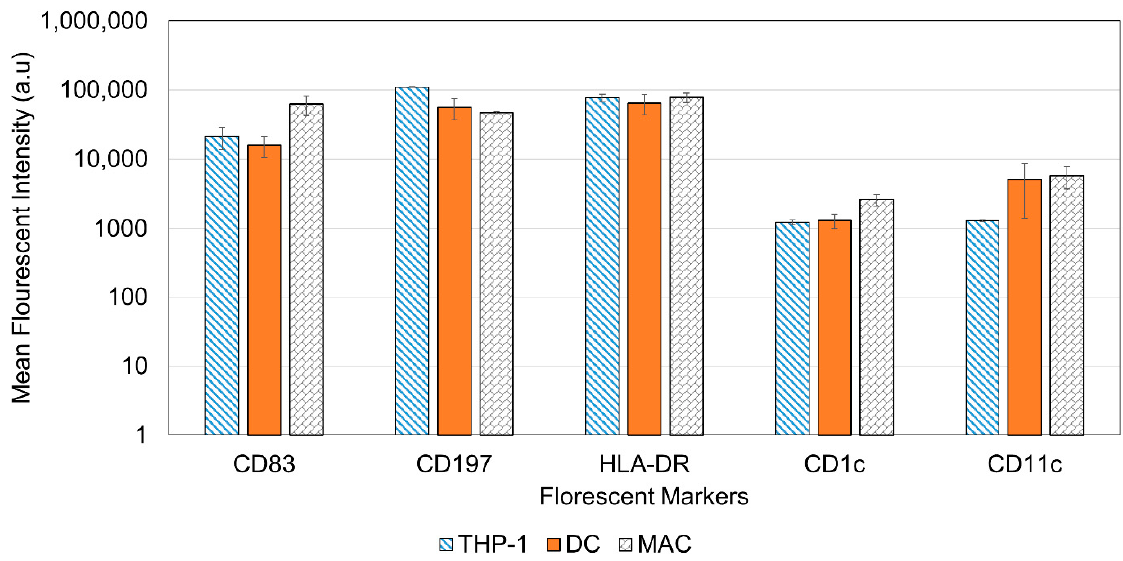
Figure 3. Average mean fluorescent intensity of different cell markers for THP-1, DCs, and MACs with S.E.M bars obtained for three measurements. Cultured cells were washed, suspended at 3 × 10 4 in 200 µ L cold FACS solution (DPBS; Gibco- Invitrogen) and incubated with FITC- or PE-conjugated monoclonal antibodies or appropriate isotypic controls for 30 min. Cells were then washed twice and resuspended in 300 µ L of cold FACS solution. Stained cells were analyzed with BD Accuri C6 plus. Cell debris was excluded from the analysis by setting a gate on forward and side scatter that included only cells that are